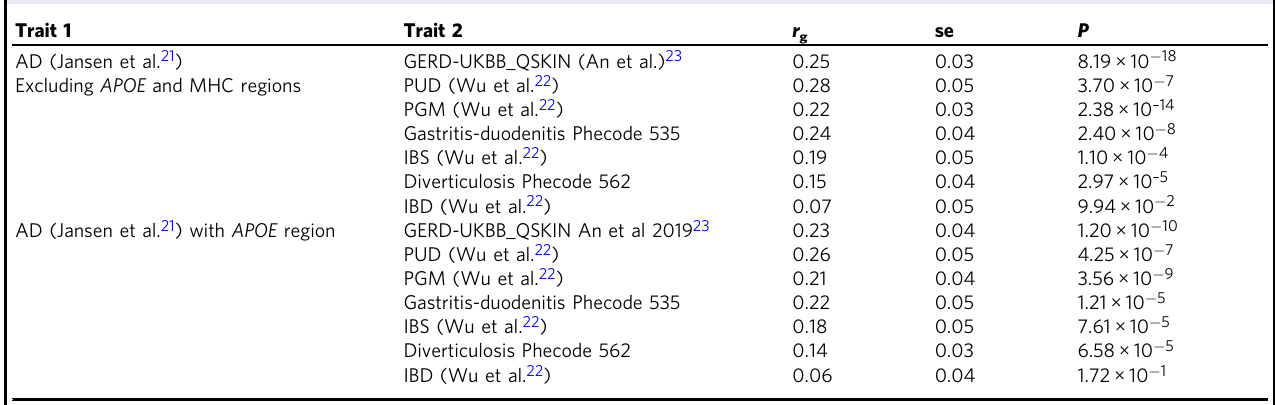
Table 2 Genetic correlation between AD and GIT disorders. Trait 1